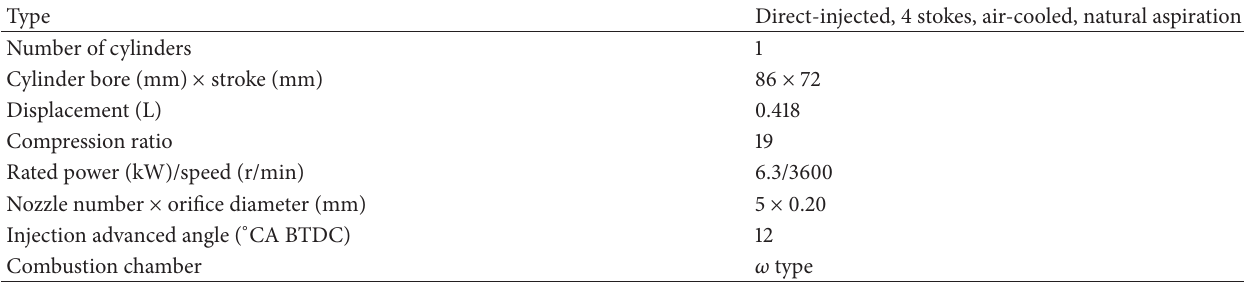
Table 2: Engine specification of 186FA.